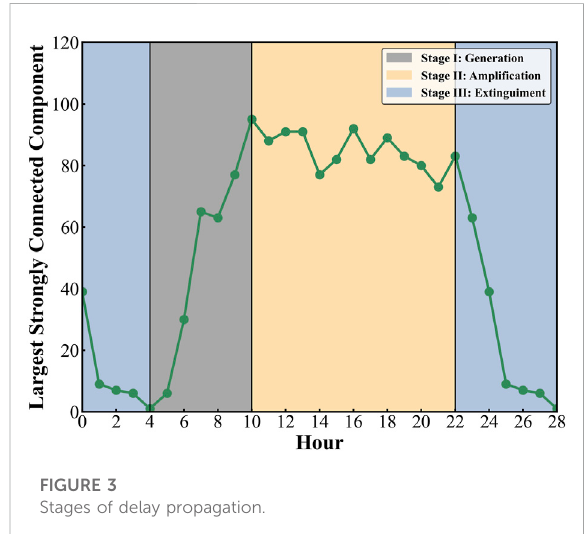
FIGURE 3 Stages of delay propagation.